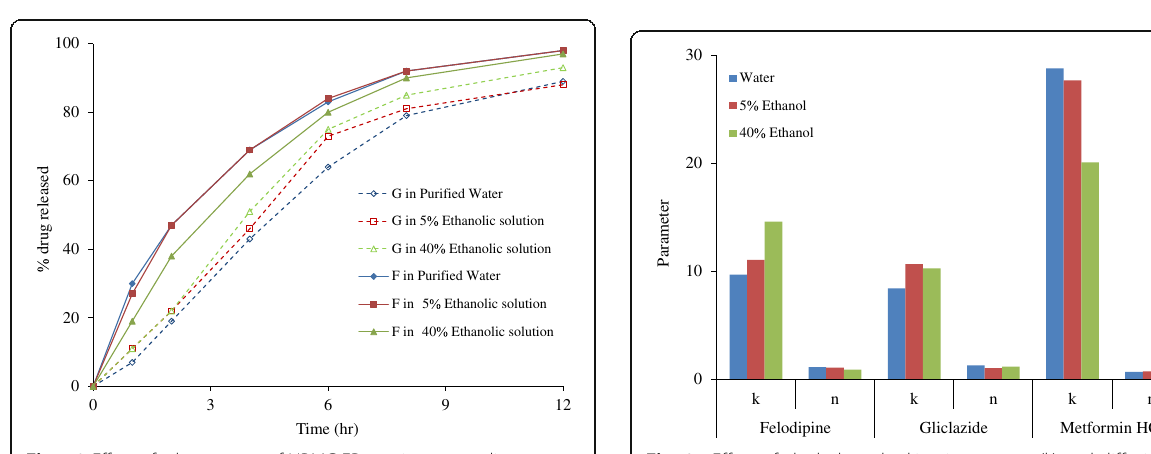
Fig. 19 Effect of 1 h exposure of HPMC ER matrices to media containing 0, 5 or 40% v/v ethanol on release profiles of gliclazide (G) and felodipine (F) (data from reference (Levina et al. 2007))